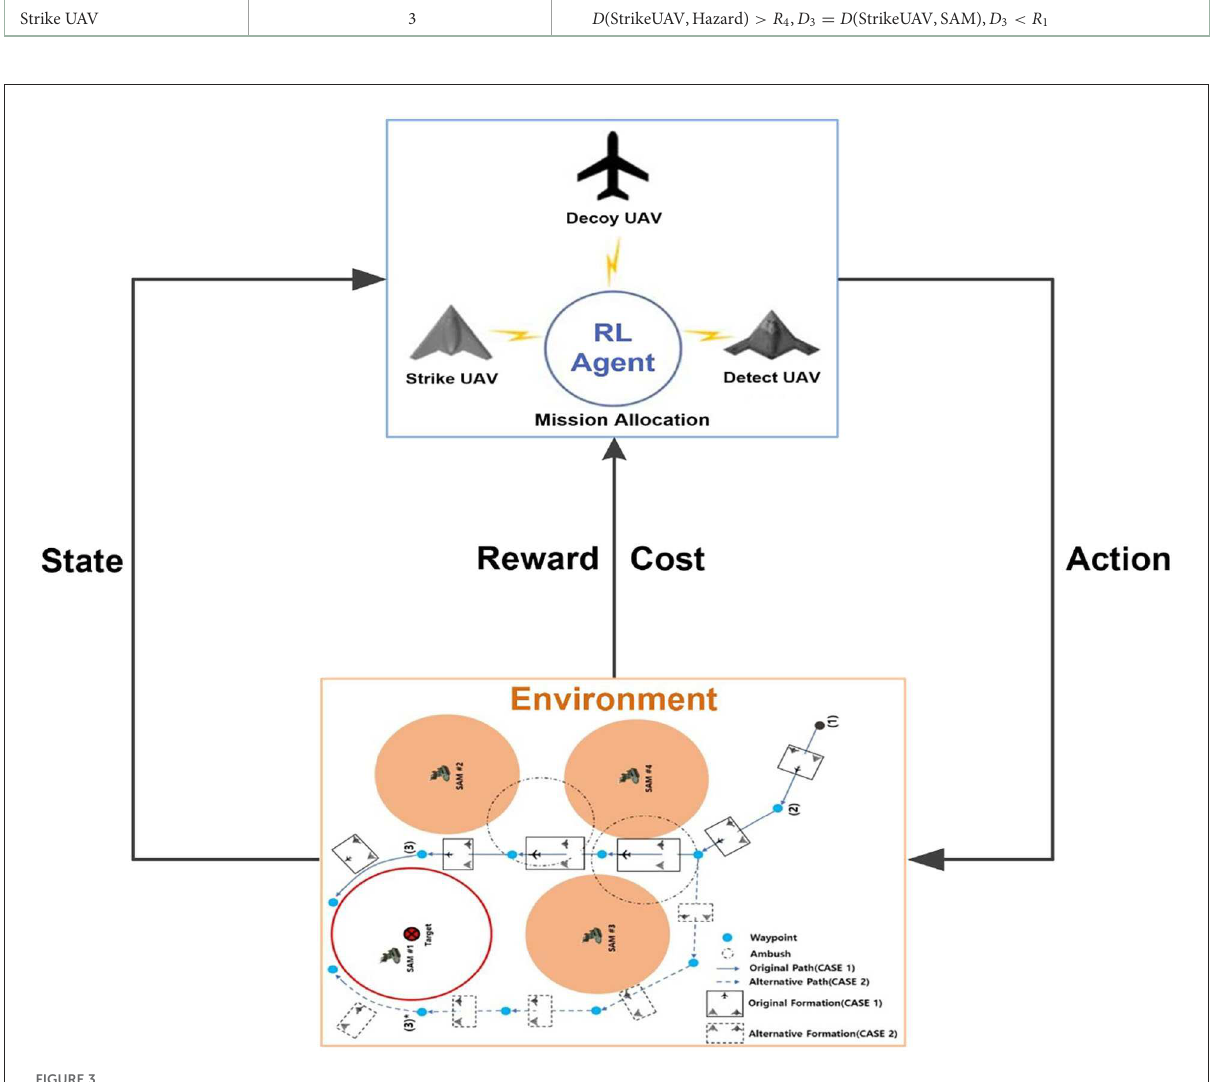
Table 1. D is a distance function. D 1 , D 2 , and D 3 indicate UAVs,